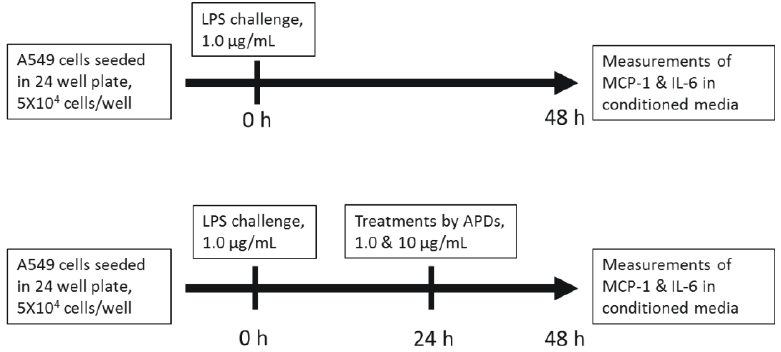
Figure 1. Preliminary screening protocols for anti-inflammation potency of APDs using the LPS-activated A549 cell model. Table 1. Secretion of MCP-1 in conditioned media of LPS-activated A549 cells treated with low (1.0 µg/mL) and high (10 µg/mL) concentrations of Dexa, paeonol, and APDs.